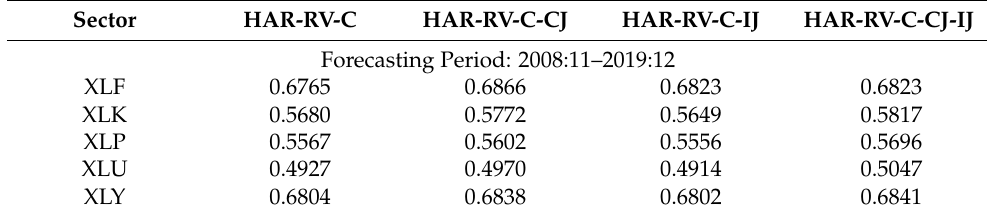
Table 12. Out-of-sample R 2 *.